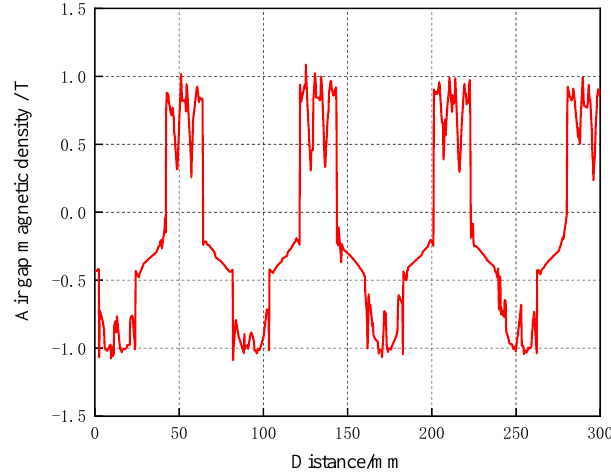
Figure 5. Flux density cloud of reverse claw-pole electrically excited generator.